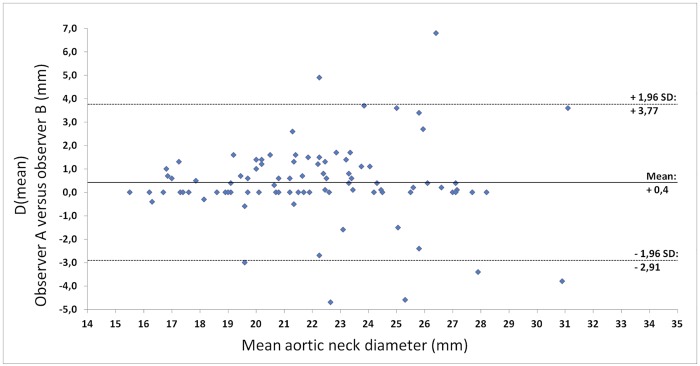
Bland-Altman plot of the differences between observer A and B for the D(mean) method.